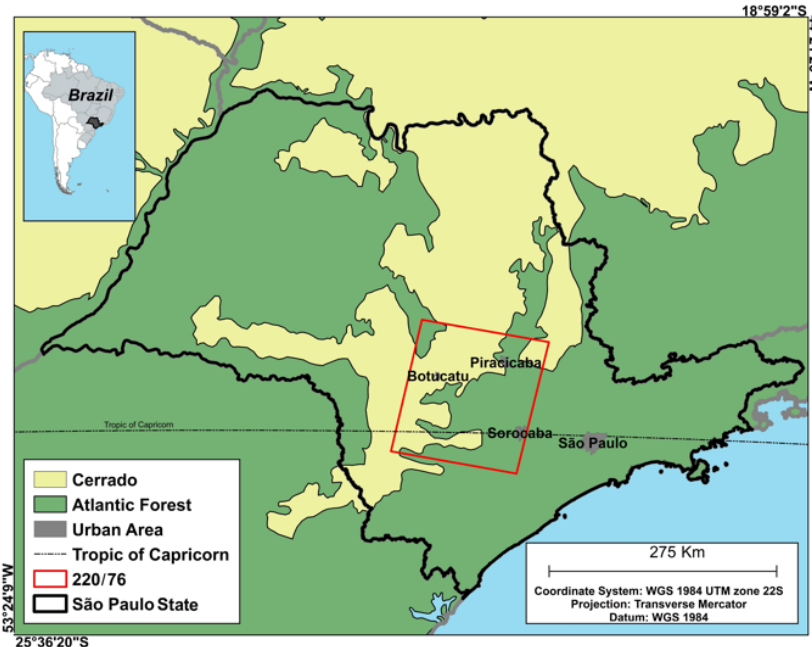
Figure 1. Location of the study area (Landsat WRS2 220/76) shown with the São Paulo State, Brazil, with the main cities (Sorocaba, Piracicaba, and Botucatu) and Atlantic Forest and Cerrado biome limits.